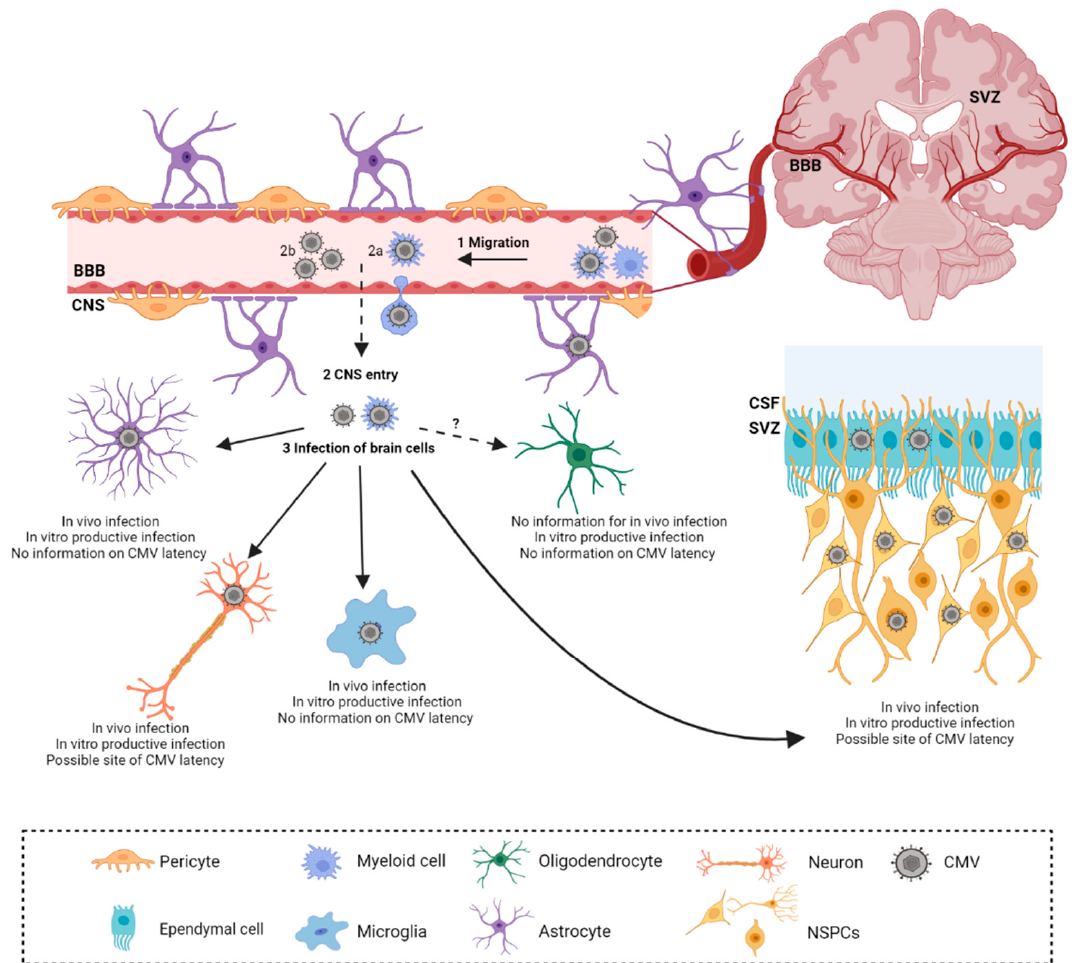
Figure 1. Cytomegalovirus infection in developing brain. Cytomegalovirus (CMV) dissemination to the central nervous system (CNS) is secondary to peripheral organ infection (1). Upon reaching the brain, CMV is hypothesized to cross the blood–brain barrier (BBB) by either cell-associated (2a) or cell-free form (2b). Monocytes are proposed to mediate cell- associated passage across the BBB. Upon crossing of the BBB, CMV infects resident cells (3). Apart from oligodendrocytes, CMV infection of resident CNS cells was confirmed in vivo. CMV DNA was detected in cerebrospinal fluid (CSF) of congenitally infected infants and neural stem precursor cells (NSPCs), abundant in subventricular zones (SVZ), are a prominent target of CMV infection. Figure was created with Biorender.